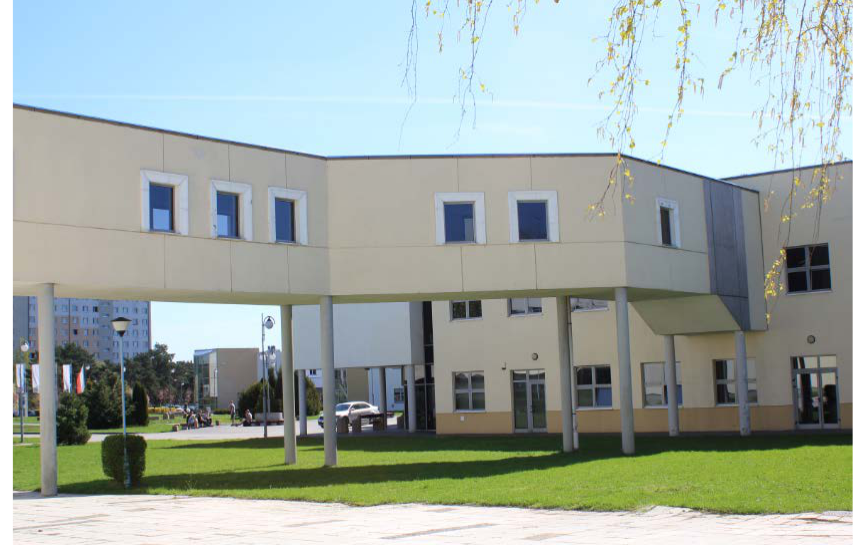
Figure 1. A view of the investigated object.